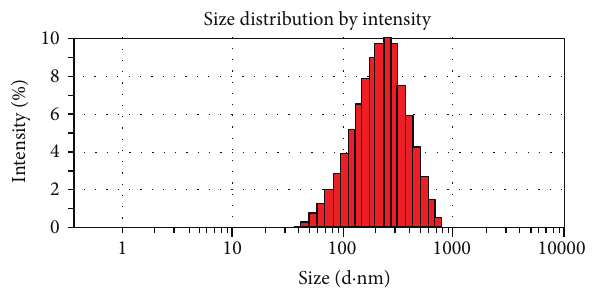
Figure 2: Particle size distribution of synthesized silver nanoparti- cles.